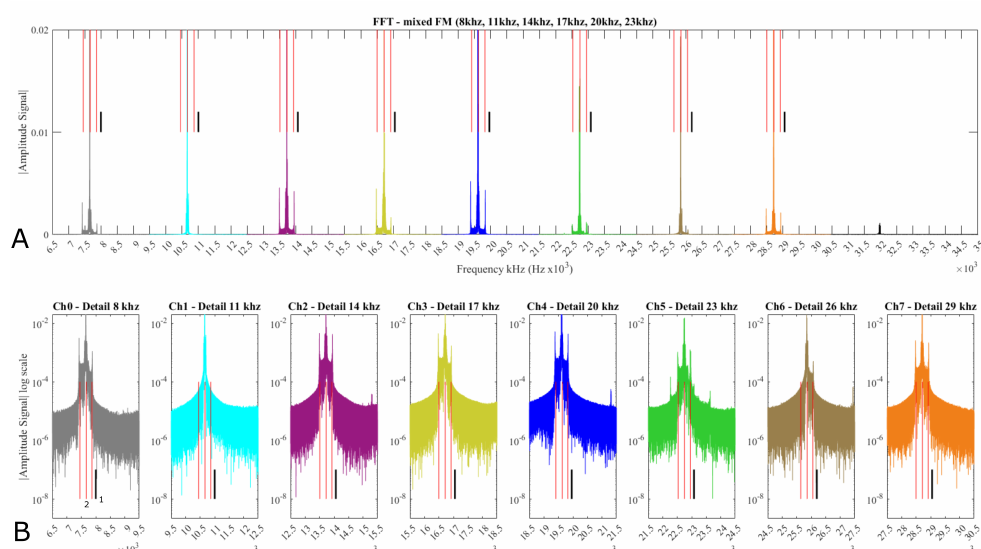
Figure 13. FFT analysis of the mixed FM signal. ( A ) presents the FM spectrum in normal scale. ( B ) in Log scale. The small vertical line (in black (1)) shows the carrier frequency position. The three thinner red lines (2) identify the peaks of the frequency deviations at − 100, − 333, and − 500 Hz from the carrier frequency that correspond to the sensor outputs 1, 2.5, and 4 V